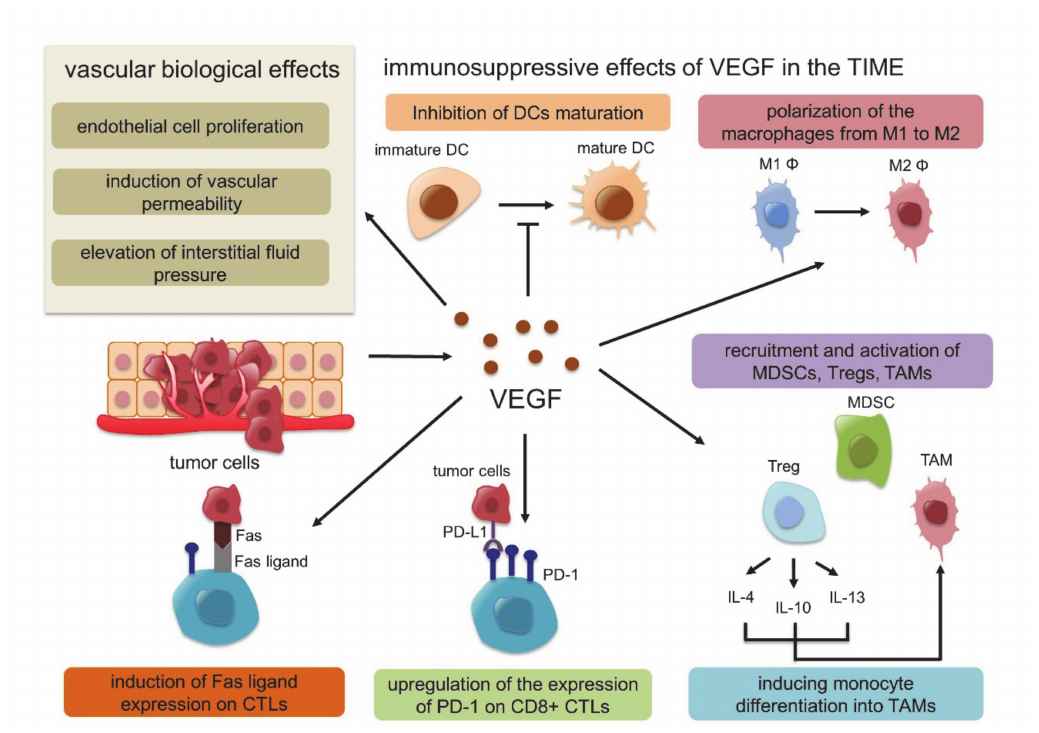
Figure 2. Vascular biological e ff ects and immunosuppressive e ff ects of vascular endothelial growth factor (VEGF) in the tumor immune microenvironment